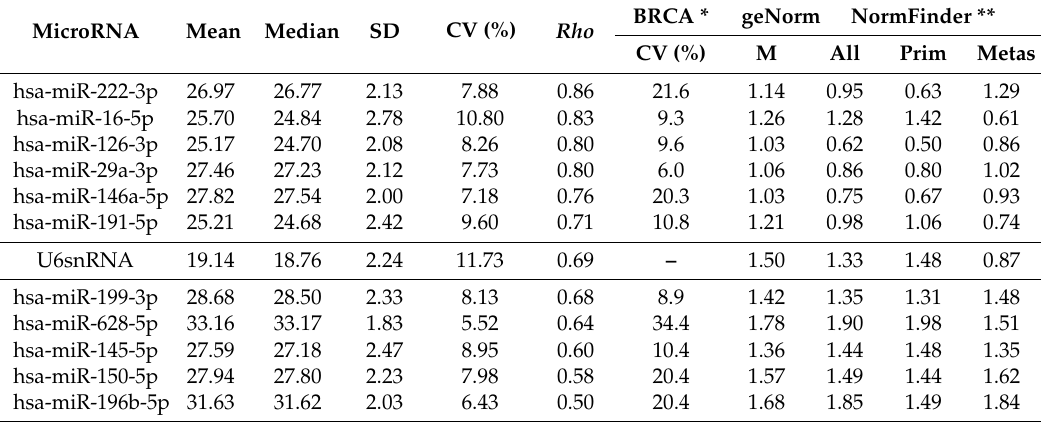
Table 1. MicroRNA expressions of housekeeper candidates.